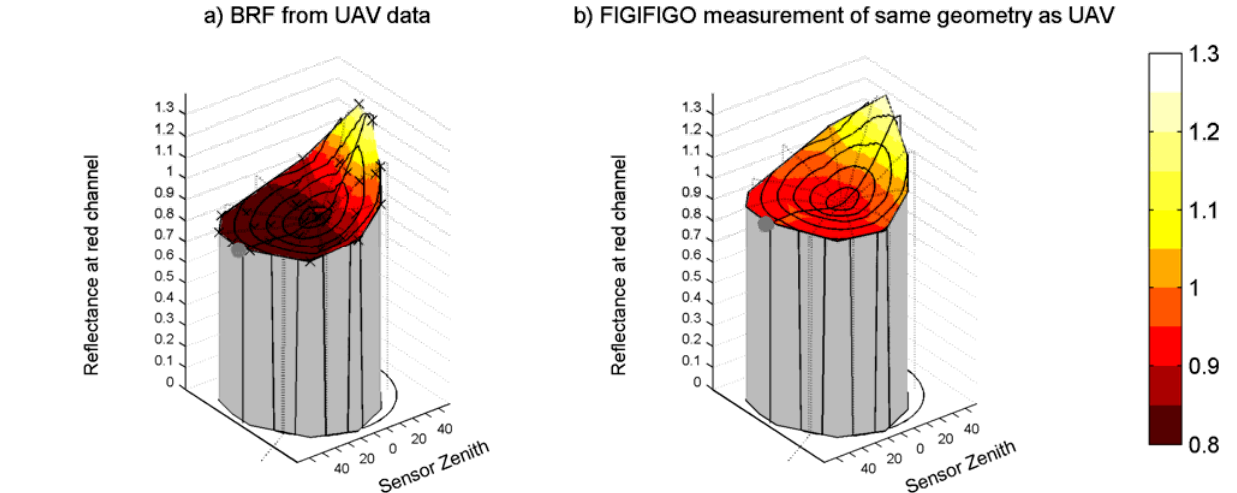
Figure 8. (a) Reflectance factor plot of an area of smooth snow measured with UAV. (b) A similar, but not the same, sample of smooth snow measured using FIGIFIGO and interpolated to the same measurement geometry as the UAV data. Similar characteristics can be seen in both samples, although the overall intensity of the UAV sample is lower and specular reflection is